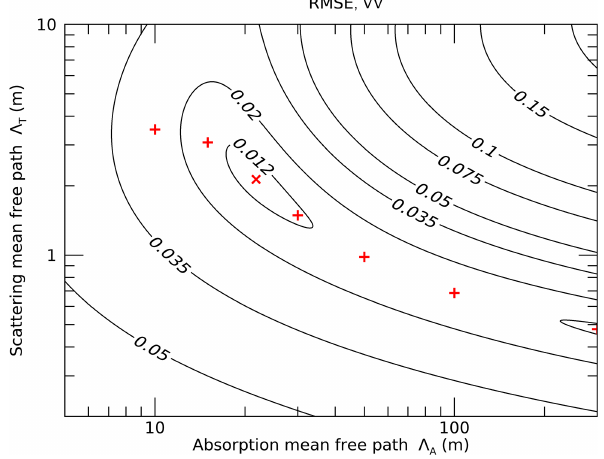
Figure 13. Contour map of root mean square error (RMSE) between measured and modeled data for TanDEM-X (Fig. 12) for different pairs of (cid:51) A and (cid:51) T . The plot shows a weak global minimum be- cause acquisitions at sufficiently large β values that could better constrain (cid:51) A were not currently available. The model parameters and RMSE values for the red “ + ” symbols are given in Table 1. For these points, the parameter value of (cid:51) T was estimated by nonlinear least-squares minimization for different choices of (cid:51) A